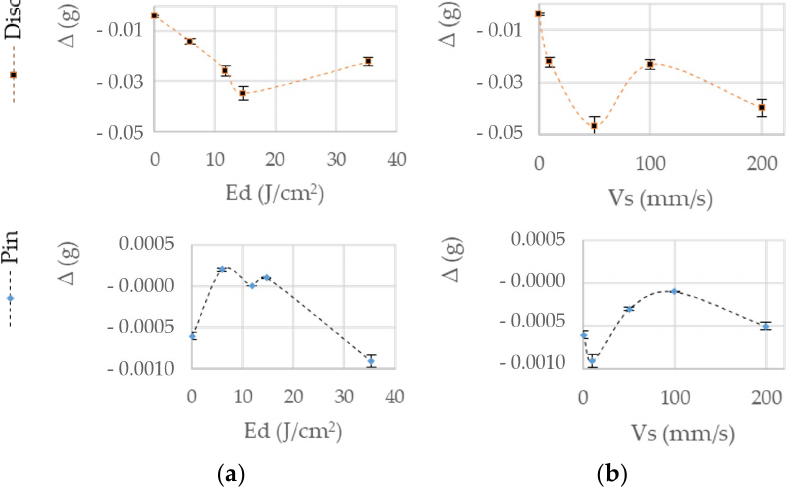
Figure 10. Wear rate based on weight variation for the disk and the pin: ( a ) For different Ed at fixed Vs = 10 mm/s; ( b ) For different Vs at fixed Ed = 35.37 J/cm 2 .